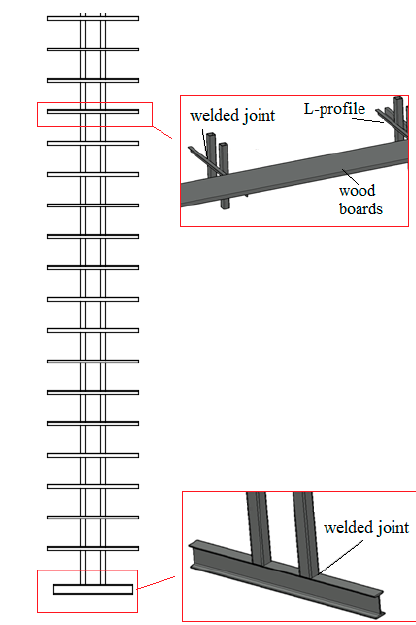
Figure 1. Typical old cheese racks collapsed after the Emilia Romagna earthquake (2012).